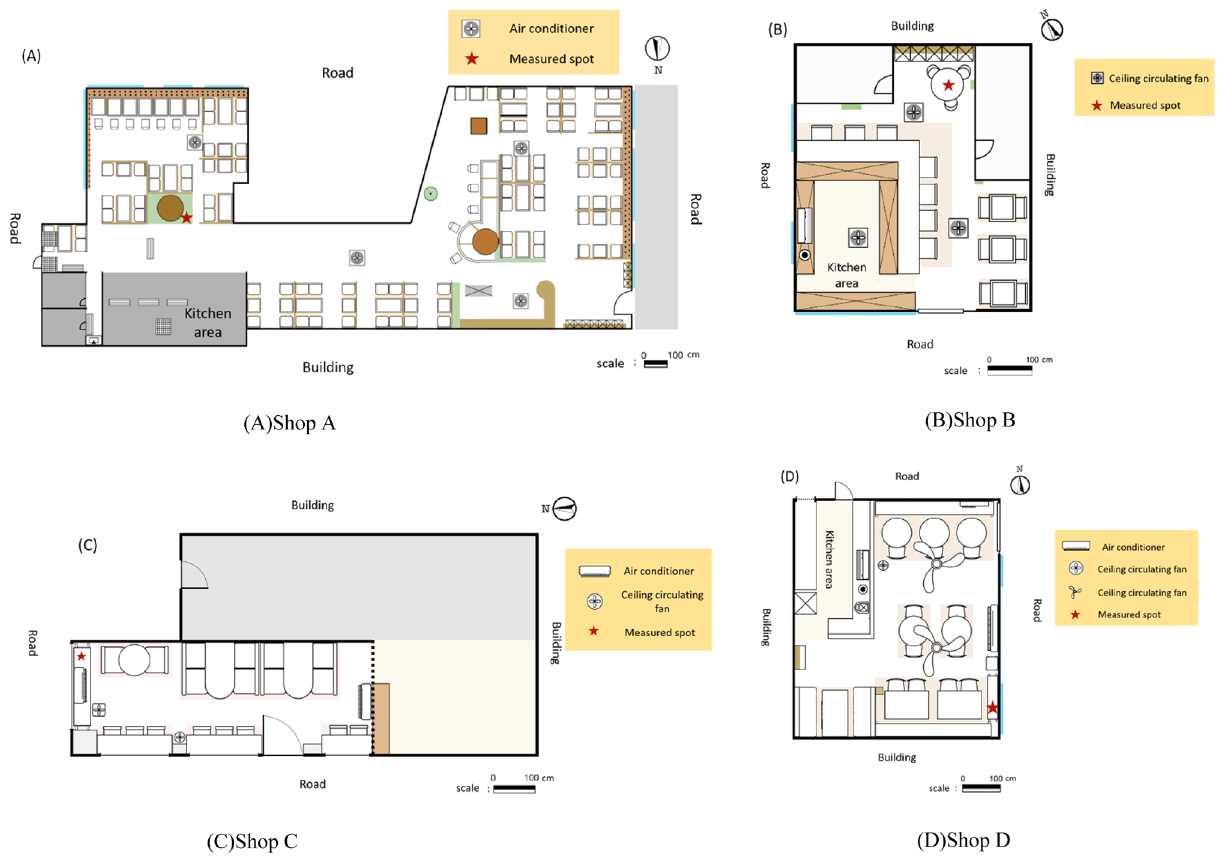
Figure 1. Floor plans and sampling points of four coffee